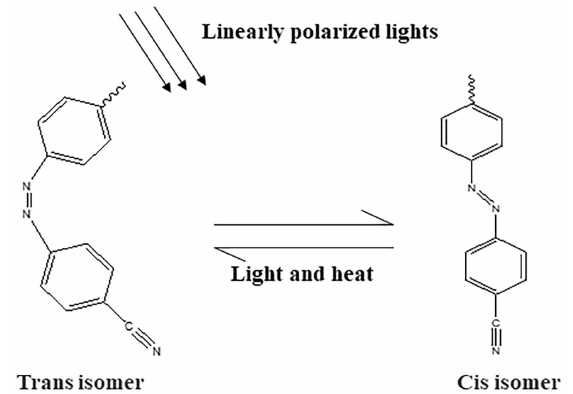
Figure 4. The cis-trans isomerization process of azo